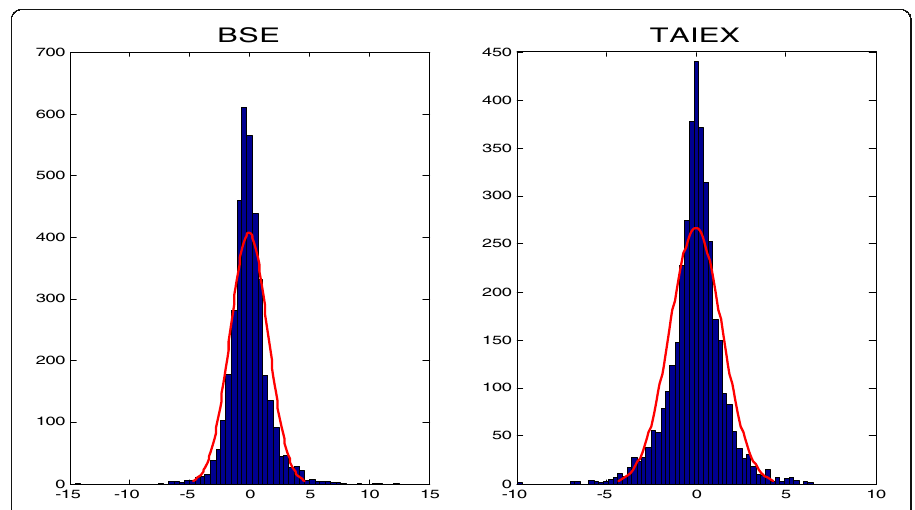
Fig. 7 Histogram of daily returns of the BSE (left) and TAIEX (right) against the theoretical normal